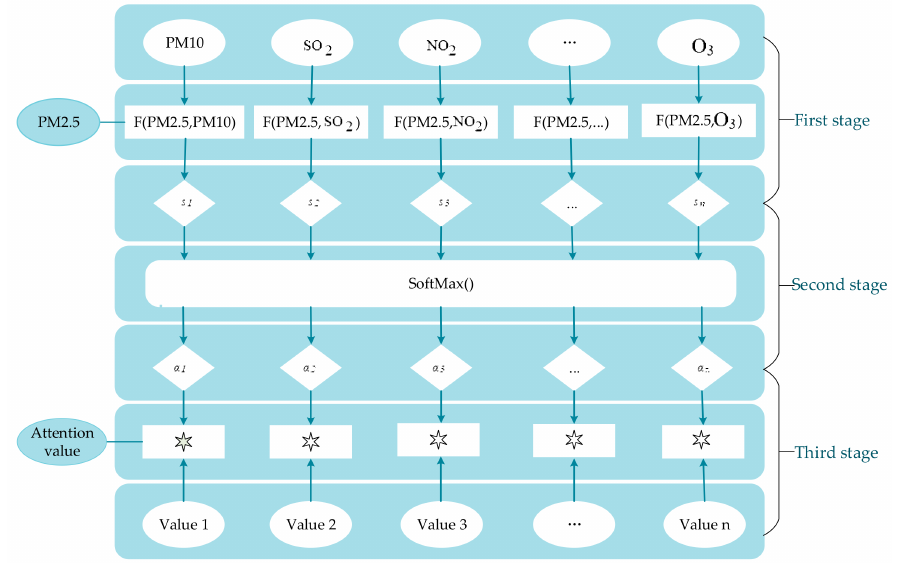
Figure 4. The process of the attention mechanism.